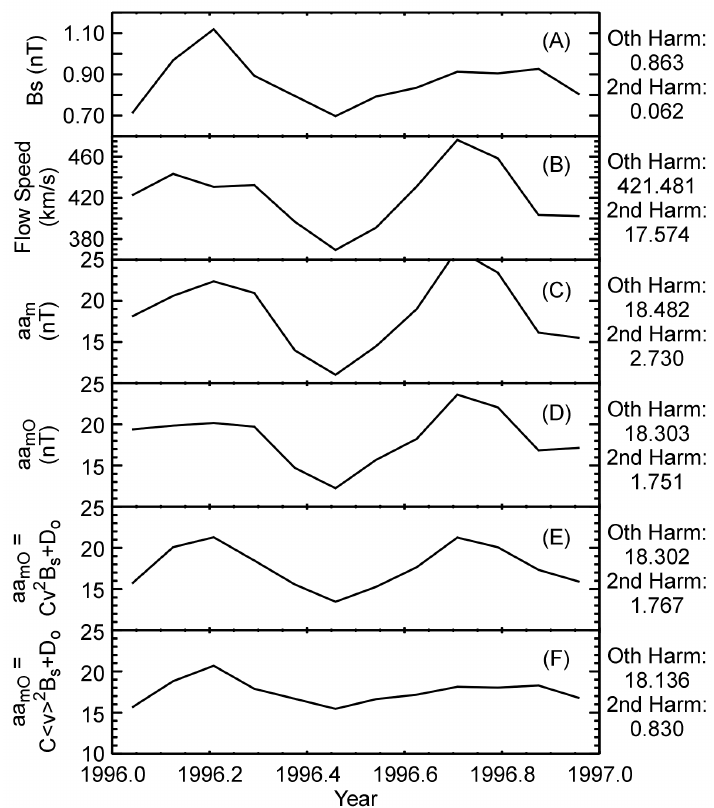
Fig. 3. Monthly averages for 1996 of (a) southward magnetic field ( B s ), (b) solar wind flow speed ( v ), (c) aa m in- dex, (d) “observed” aa m 0 index, (e) cal- culated aa m 0 index (from Eq. 1; C = 7 . 551 × 10 − 5 ,D O = 6 . 554), and (f) calculated aa m 0 index with solar wind flow speed ( v ) held constant at its yearly average of 421kms − 1 . The average value (0th harmonic) and coefficient of the 2nd harmonic of each parameter are given in the right-hand